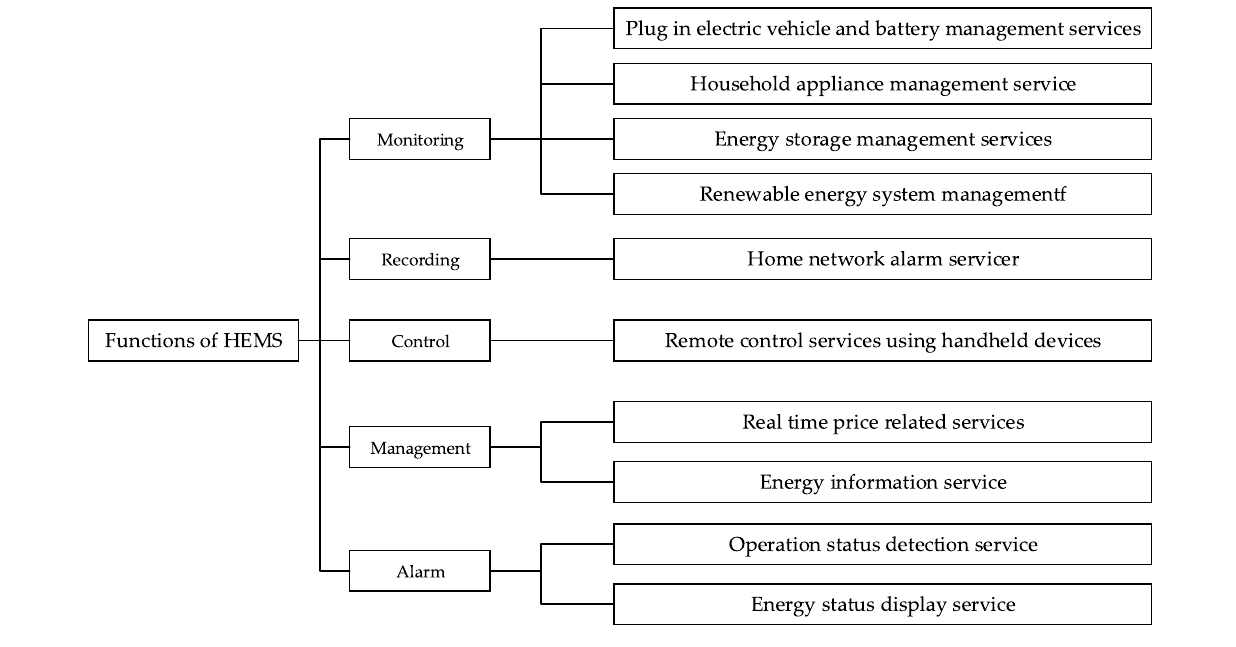
FIGURE 4 | Five functional modules of the